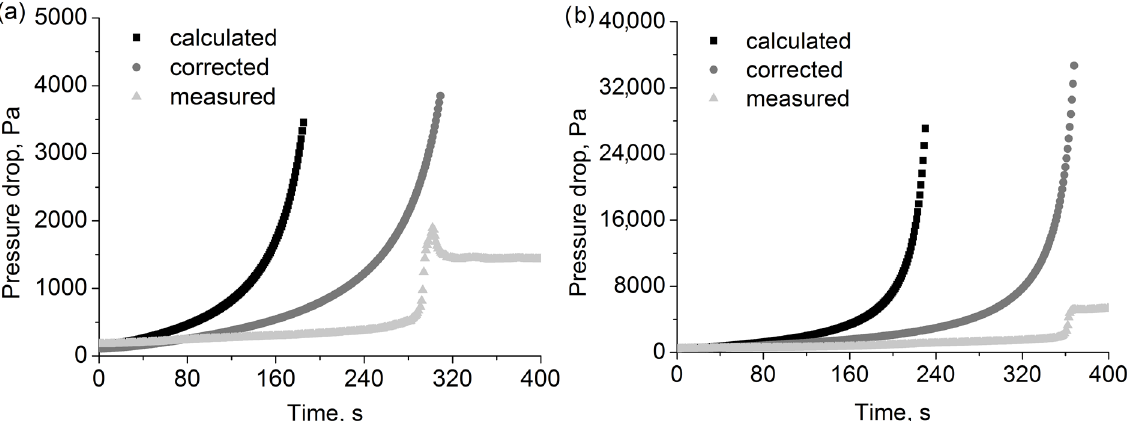
Figure 12. Pressure drop measured and calculated during filtration of water + oil aerosol for ( a ) 2F6 and ( b ) F1 filters.